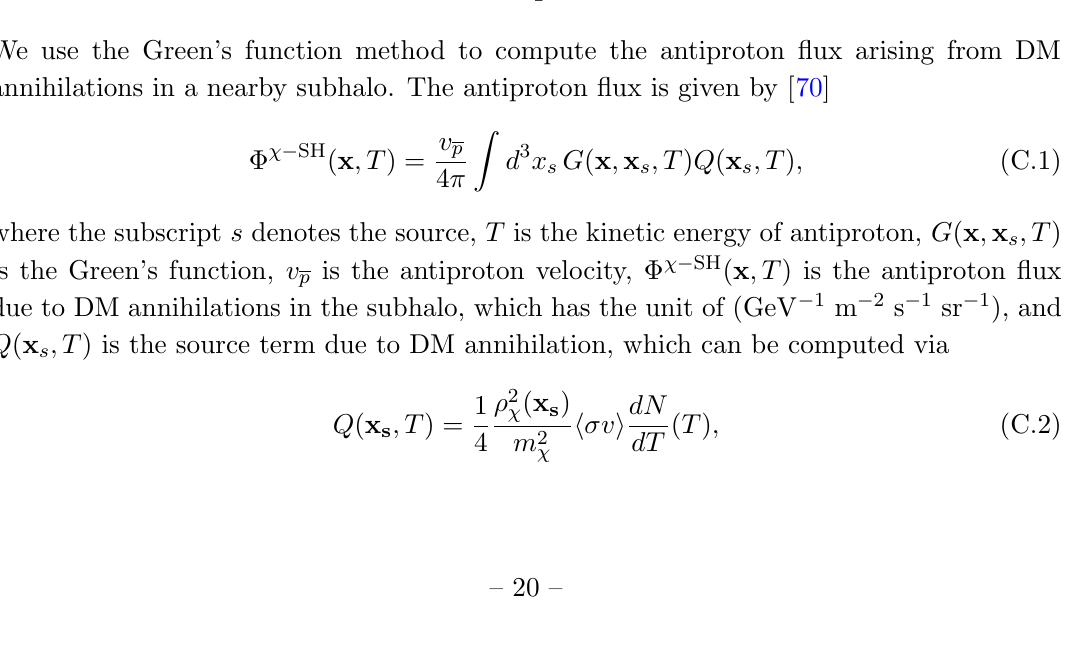
Figure 16 . HESS 95% CL upper bound on the total gamma ray (cid:13)ux (cid:8) 95 160 GeV < E (cid:13) < m (cid:31) [59]. The 2 (cid:22) (2 (cid:28) ) curve is obtained based on the HESS upper bound on the annihilation cross section curve in the (cid:31) (cid:22) (cid:31) ! (cid:22) + (cid:22) (cid:0) ( (cid:31) (cid:22) (cid:31) ! (cid:28) + (cid:28) (cid:0) ) channel [59]. The \average" curve is the arithmetic mean of the 2 (cid:22) and 2 (cid:28)